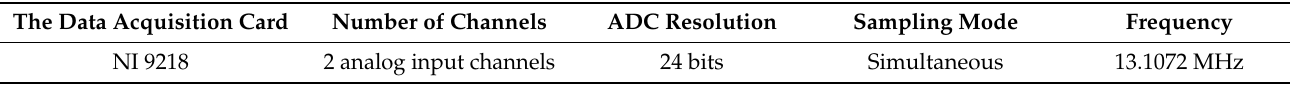
Table 1. The main parameters of the DAQ system 1 .